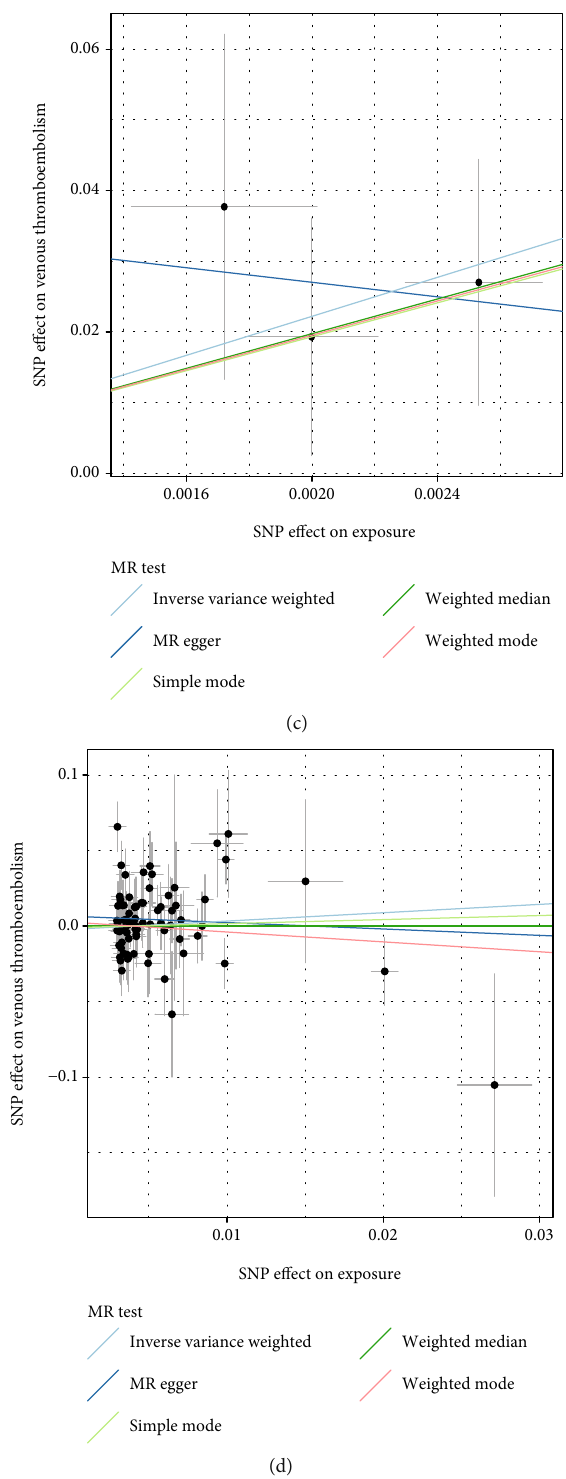
Figure 2: Scatter plots for the association of FSH-, TSH-, hyperthyroidism-, and hypothyroidism-associated SNPs with risk of venous thromboembolism. (a) FSH, (b) TSH, (c) hyperthyroidism, and (d) hypothyroidism. In the scatter plot, x -axis represents SNP e ff ects on FSH, TSH, hyperthyroidism, and hypothyroidism (SD), and y -axis represents venous thromboembolism risk (log OR and 95% CI). The Mendelian randomization regression slopes of the lines denote the causal estimates utilizing fi ve methods (IVW, MR-Egger, weighted median, simple mode, and weighted mode). Abbreviations: SNP: single nucleotide polymorphism; TSH: thyrotropin; OR: odds ratio; CI: con fi dence